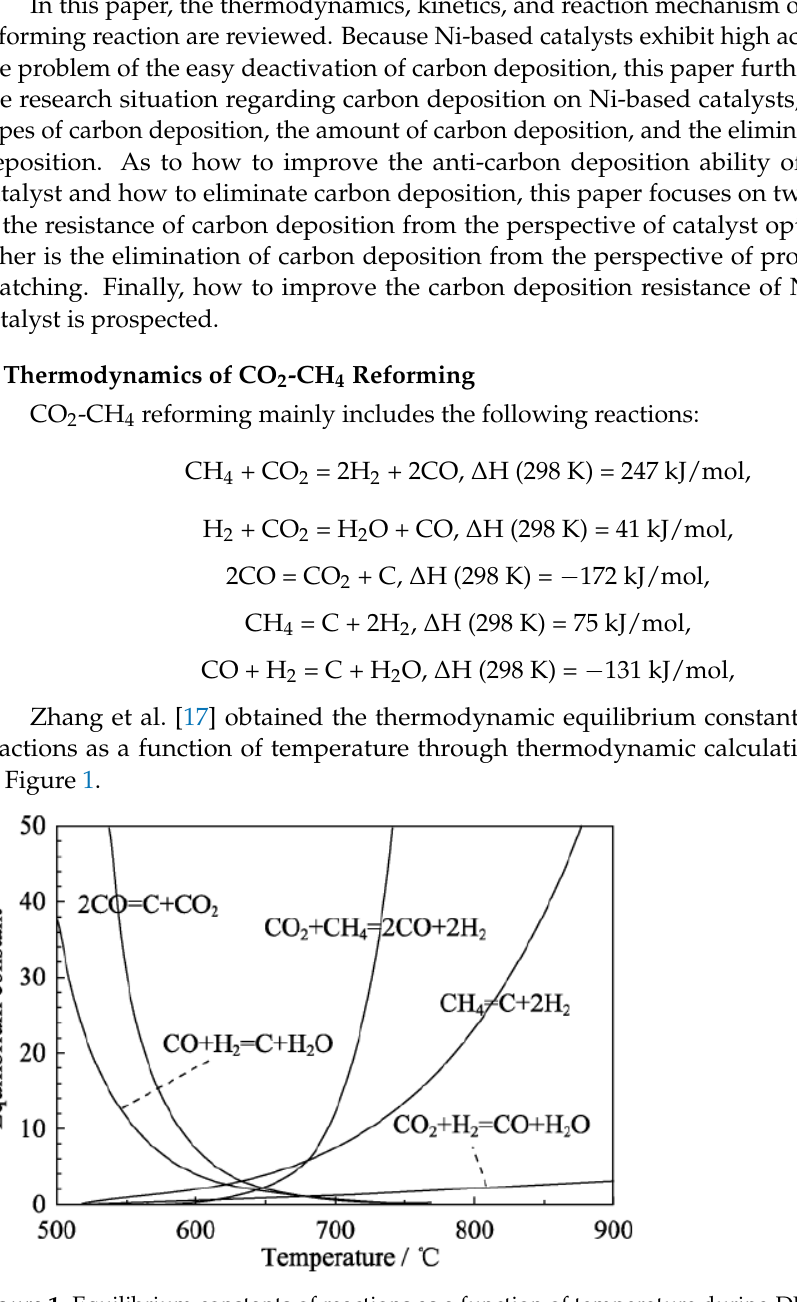
Figure 1. Equilibrium constants of reactions as a function of temperature during DRM [17]. As both methane and carbon dioxide are very stable, CRM is an extremely strong endothermic reaction. Meanwhile, the RWGS reaction is an important side reaction in the CRM process which reduces the H 2 /CO ratio in the product [18,19]. In the CRM reaction process, high temperature (>1000 K) and low pressure (~1 atm) are usually required to obtain the efficient conversion of methane and carbon dioxide to syngas. At a